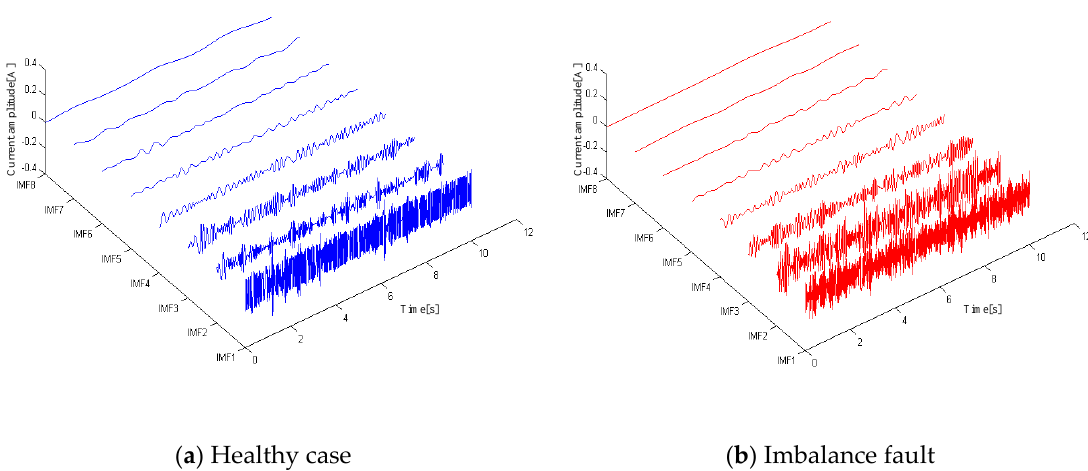
Figure 12. Decomposition results of an EMD-based filter bank.